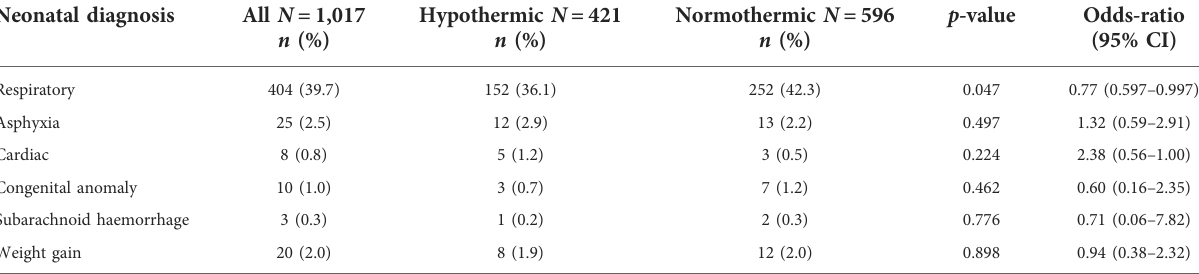
TABLE 6 Neonatal diagnoses among study participants.